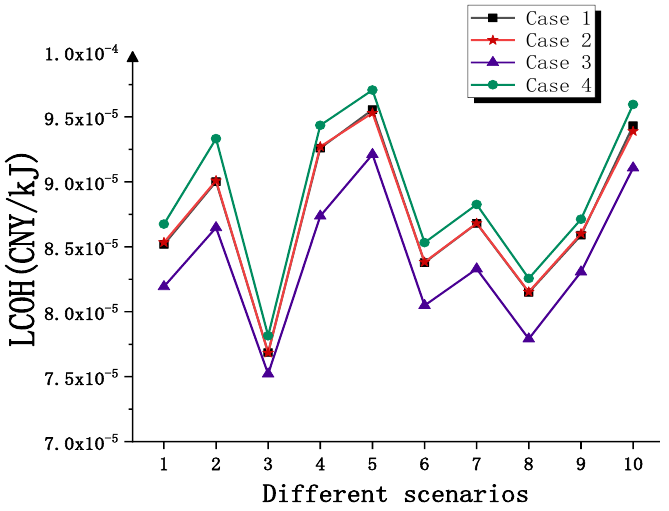
Figure 10. Comparison of minimum LCOHs among the four operation strategies (CNY can be converted into USD based on CNY 1 = USD 0.1496 on 1 June